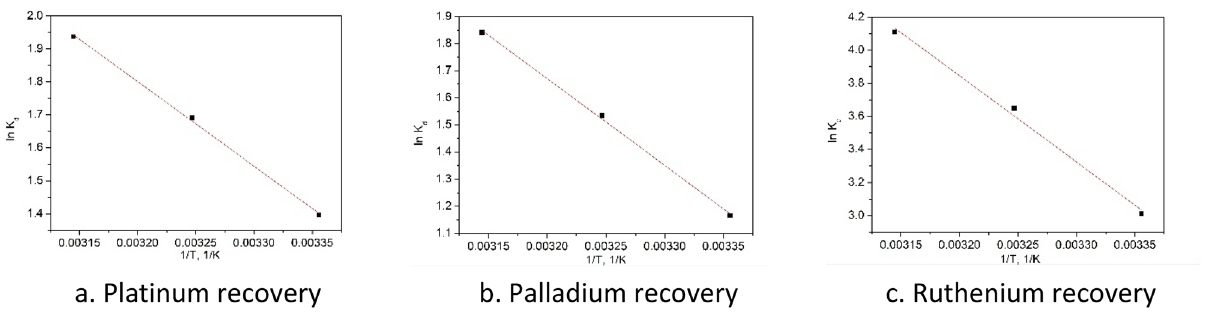
Figure 11. ln K d versus 1/T for adsorptions on Ch-DB18C6.